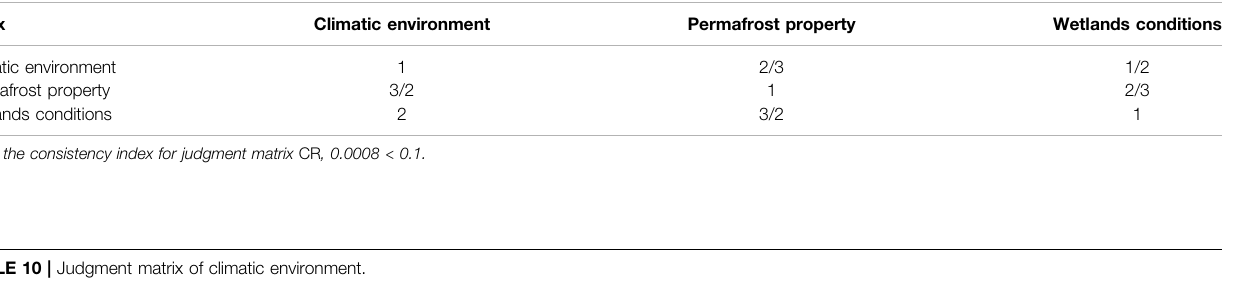
TABLE 9 | Judgment matrix of evaluation index for rule set.